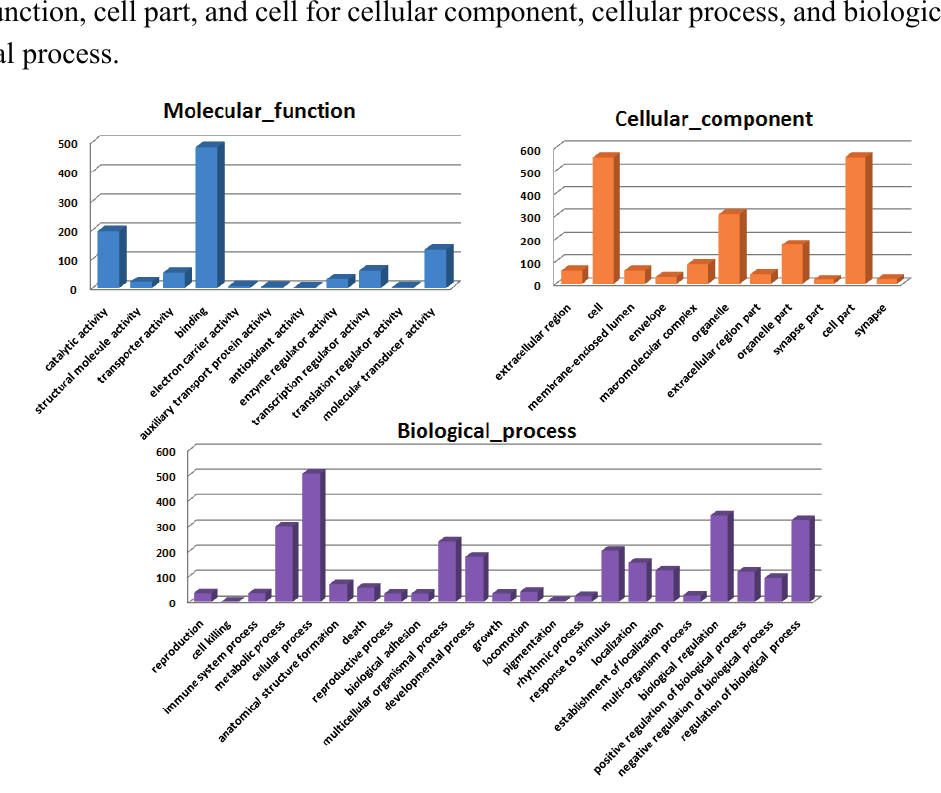
Figure 4. GO ontology analysis of genes for which radiation-induced alteration of expression was abolished or attenuated by HSC. Gene ontology (level 2) for the transcriptome under Molecular_function, Cellular_component, and